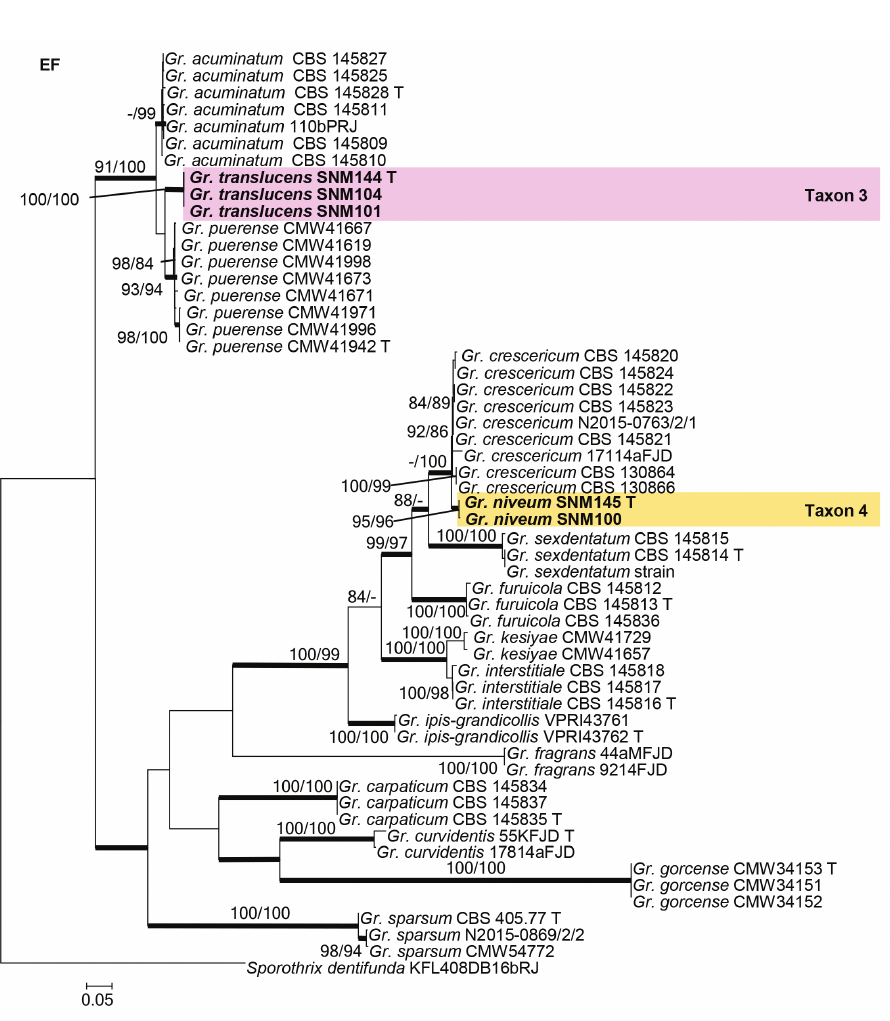
Figure 5. Maximum likelihood phylogeny of Graphilbum using partial EF gene region. The isolates re- covered in this study are highlighted in color and in bold font. ML and MP bootstrap support values ≥ 75 are indicated at the nodes as ML/MP. Bold branches indicate posterior probabilities values ≥ 0.9. T indi- cates ex-type